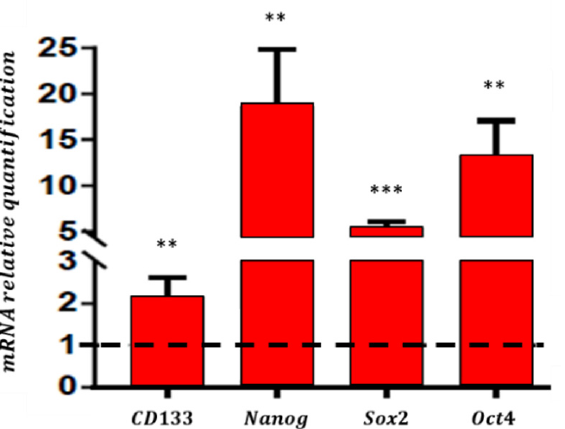
Figure 8. Comparative analysis of gene expression of four undifferentiated markers: CD 133, Nanog , Sox 2 and Oct 4 among U87-MG cell line, cultured in Normal Medium (dotted line), or in define medium, measured by Real Time PCR. *** represents p -value < 0.001, ** represents p -value < 0.01.